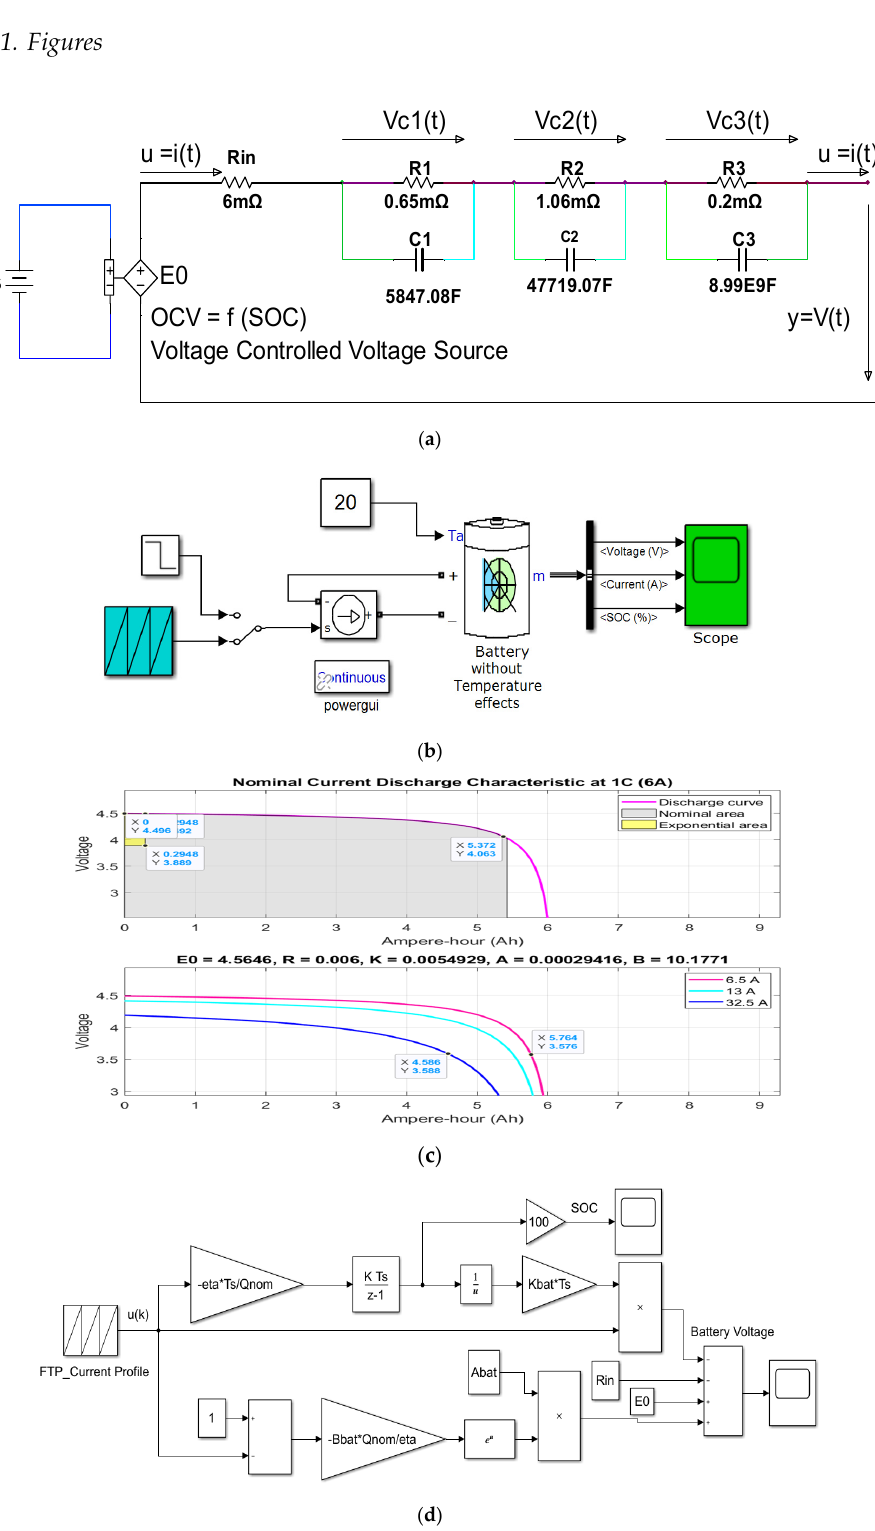
Figure A1. The Li-ion Battery—3RC ECM and Simscape models: ( a )Li-ion battery represented in NI Multisim 14.1 editor (see Figure 6—Part 1); ( b ) Simscape Simulink diagram of Li-ion battery (see Figure A19—Part 1); ( c ) Simscape SAFT Li-ion battery nominal current discharge characteristic @1C (6A) (top side view); @6.5A, 13A and 32.5A. ( d ) Simulink diagram of Li-ion Simscape generic model.